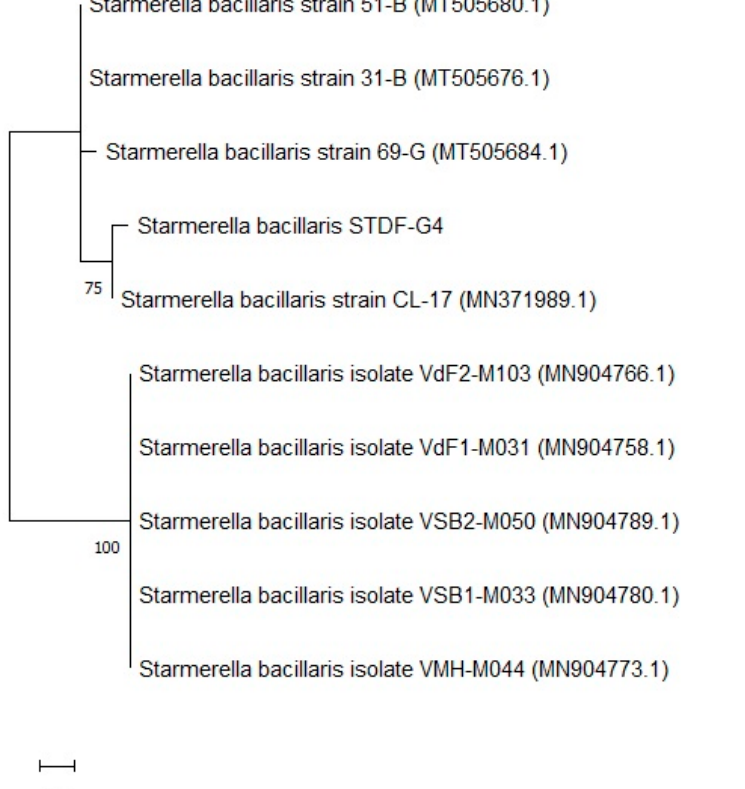
Figure 11. Effect of inoculum size on the production of bioethanol using G4 yeast isolate and the residual glucose concentrations.